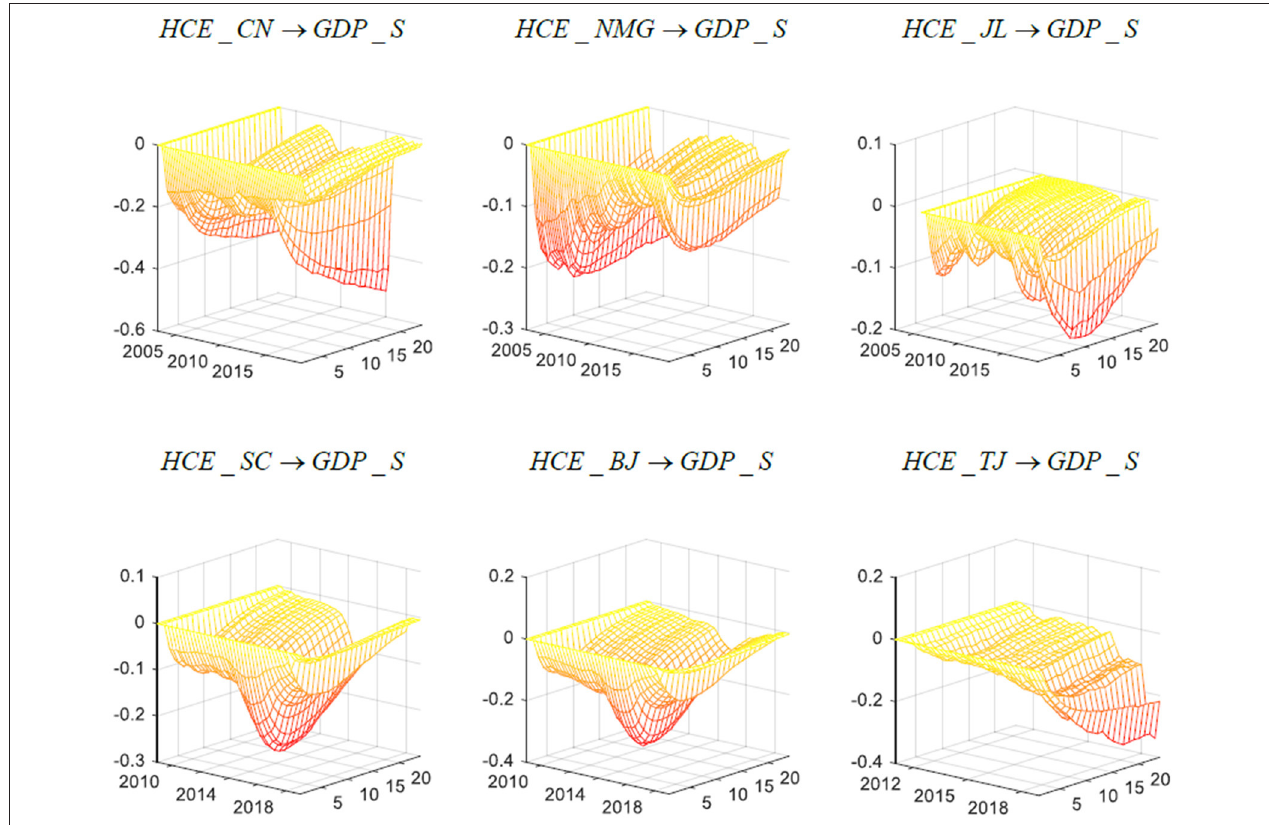
FIGURE 1 | Three-dimensional impulse response of China’s short-term economic growth in different regions. Each subfigure with the title of “ X → Y ” demonstrates the response of variable Y to an orthogonalized positive shock to variable X. In other words, X is an impulse variable, and Y is a response variable. One period in the figure denotes one